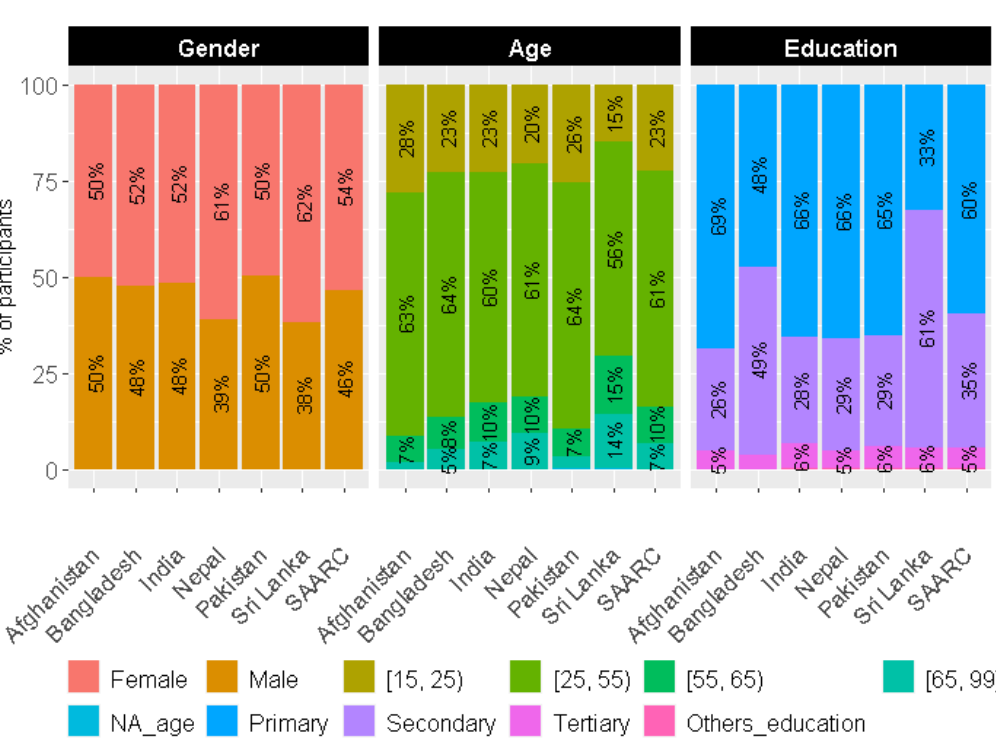
Figure 1. Demographic information of participants from SAARC countries .